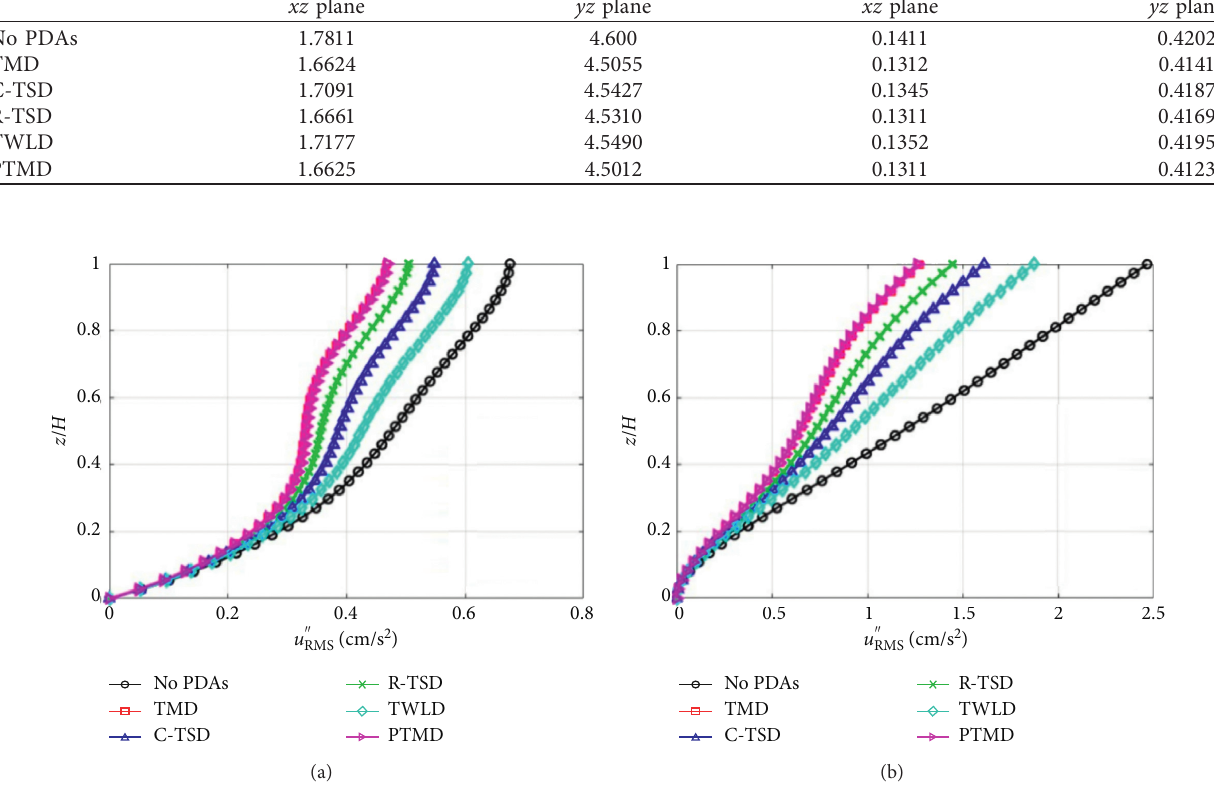
Figure 17: Along-wind RMS accelerations of the building. (a) xz plane. (b) yz